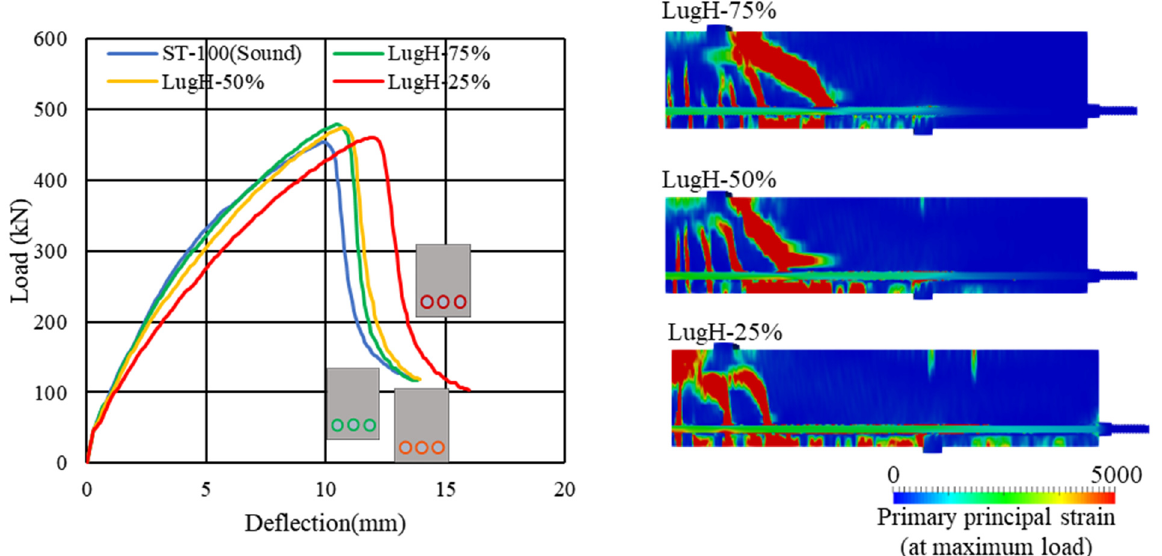
Figure 13. Analysis results (effect of lug height loss).